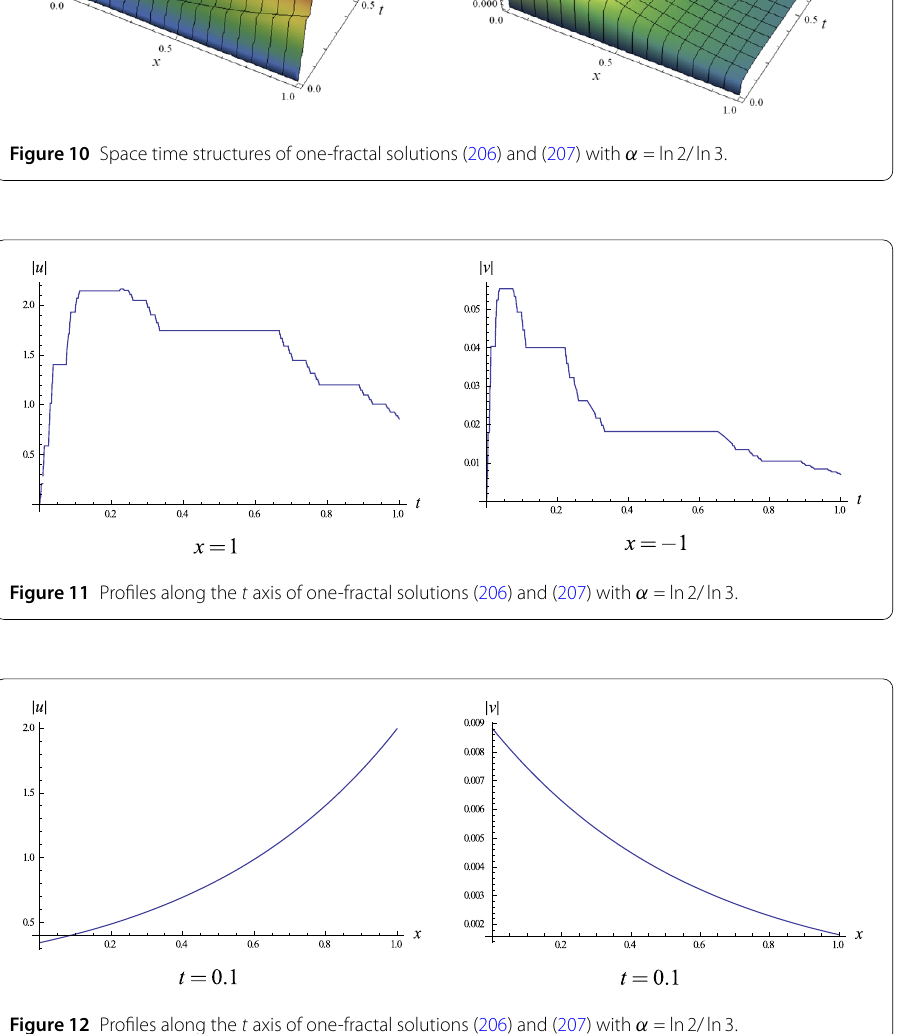
analytical methods for solving soliton equations in the field of nonlinear sciences, which are extended to the stfisAKNS and tfnisAKNS hierarchies by introducing the fractional order bilinear operators [27] and fractional order scattering data (see [24] for our prelim- inary work). Compared with the existing literature, the work of this paper is novel. For the comparisons, we would like to point out that when α = 1, both the derived stfisAKNS and tfnisAKNS hierarchies and the obtained N -fractal solutions become the known hier- archies [3, 7] and their corresponding exact solutions [3, 5, 7]. All the derived fractional AKNS hierarchies and the obtained N -fractal solutions benefit from the local fractional order partial derivatives with graceful properties [16] and the existing results [3] about the spectral problem (25) which are valid for the tfnisAKNS hierarchy